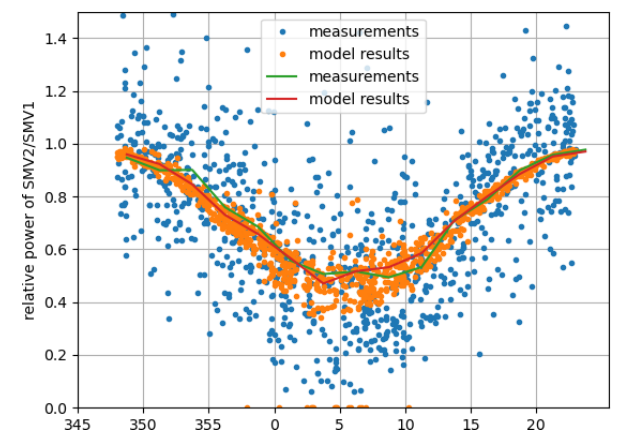
Figure 10. Comparison of measurements and P16 model outputs for calibration period, SMV2 compared to SMV1. The y axis shows relative power of SMV2 and SMV1, and the x axis indicates the incoming wind direction in ( ◦ ). Solid lines are the binned average of the measurements and model results indicated as